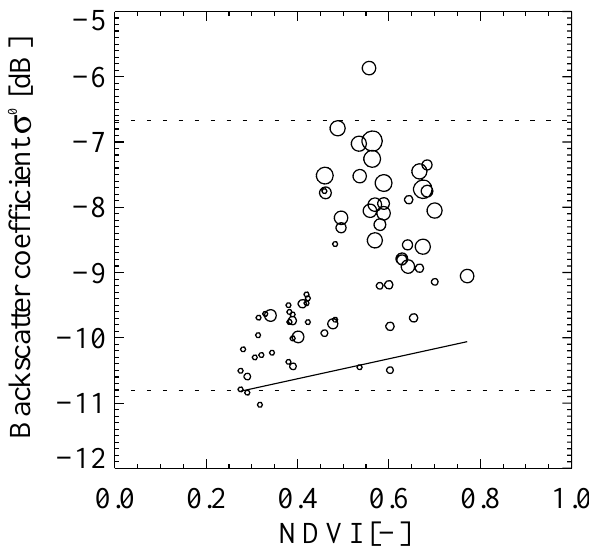
Fig. 12. Scatterplot of NDVI and ASAR WS backscatter for a pixel time series over arable land; the size of the dots represents 2 model (large dots indicate high moisture levels). Dotted lines represent the average values of the 5% highest, respectively lowest, backscat- ter coefficients, the full line indicates the vegetation dependence of ASAR WS backscatter at low moisture